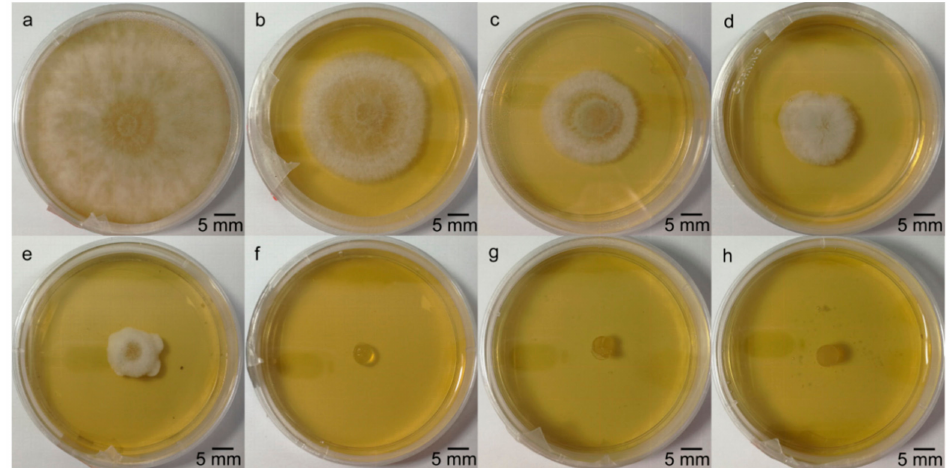
Figure 9. In vitro growth status of B. dothidea (3 days) under di ff erent concentrations of aqueous garlic extract (the Petri dish inner diameter is 55 mm) ( a ) control; ( b ) 1 mg / mL; ( c ) 2.5 mg / mL; ( d ) 5 mg / mL; ( e ) 7.5 mg / mL; ( f ) 10 mg / mL; ( g ) 50 mg / mL; ( h ) 100 mg /